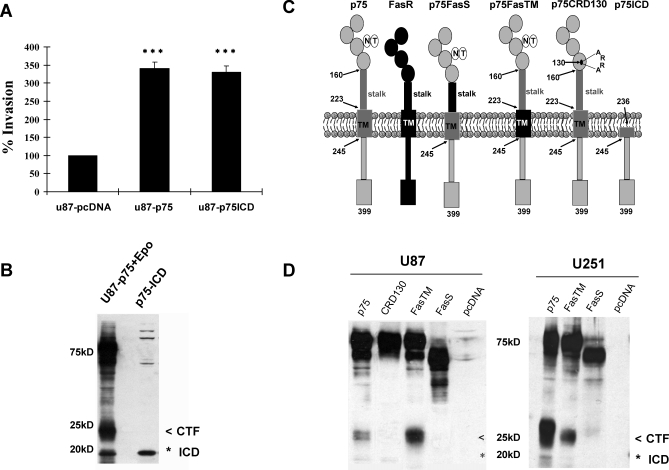
Expression and Proteolytic Processing of p75NTR Chimeric Alleles(A) p75NTR ICD is sufficient to induce invasion of U87 glioma cells in vitro. 3D-collagen invasion assays of U87p75ICD cells were performed by mixing cells with 3D-collagen matrix (collagen, fibronectin, and laminin) and then seeding them into 8.0-μm pore size transwell chamber for 6 h. Cells were fixed and stained, and invasive cells were counted. U87pcDNA and U87p75 cells were used for comparison. Values shown are the mean ± s.e.m. from three independent experiments; triple asterisks (***) indicate p < 0.001 as compared to U87pcDNA (one-way ANOVA with the Neuman-Keuls post-test).(B) Western blot analysis detected a p75NTR-positive fragment migrating at 19 KDa in U87 cells expressing the p75-ICD construct. U87p75NTR glioma cells treated with the proteasome inhibitor epoxomicin (Epo, 2 μM) were used as a positive control (U87-p75+Epo; the less than symbol [<] indicates CTF; the asterisk [*] indicates ICD).(C) Schematic diagram of the p75NTR constructs. Chimeric proteins were created by replacing either the transmembrane (TM) or the extracellular stalk (S) domain of p75NTR with equivalent domains from the Fas receptor. The proteins were designated p75FasTM (FasTM) and p75FasS (FasS), respectively. Other p75NTR constructs were generated, including the neurotrophin-binding mutant in which the ligand-binding site was mutated by inserting four amino acids after amino acid residue 130, designated p75CRD130 (CRD130), and the p75NTR intracellular domain construct consisting of amino acids 238 to 399 (p75-ICD).(D) Western blot analysis using a polyclonal p75NTR antibody to the intracellular domain of p75NTR confirmed the proper expression and processing of all p75NTR constructs (p75FL, p75FasTM, p75FasS, or p75CRD130) in both U87 (left panel) and U251 (right panel) human glioma cell lines (the less than symbol [<] indicates CTF; the asterisk [*] indicates ICD). To examine comparable levels of chimeric proteins, lysates were adjusted accordingly.